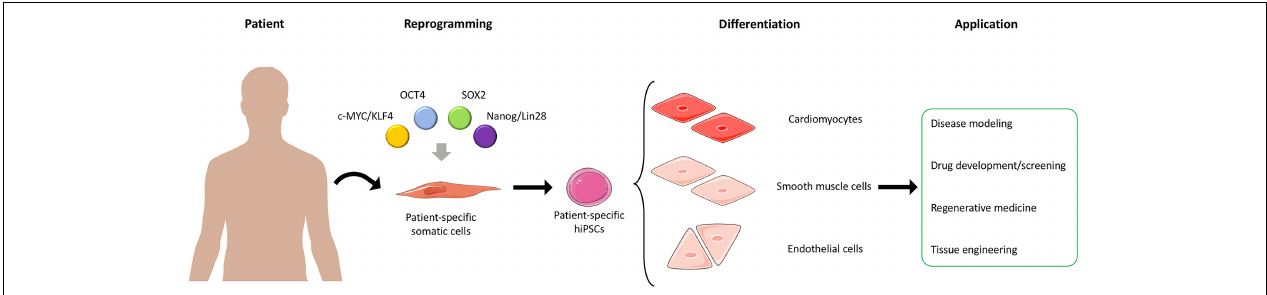
FIGURE 1 | Generation and application of hiPSCs. Somatic cells are harvested from patients and reprogrammed into patient-specific hiPSCs. The hiPSCs can then be differentiated into different cell types, such as cardiomyocytes, smooth muscle cells, and endothelial cells, which can be used in different applications.